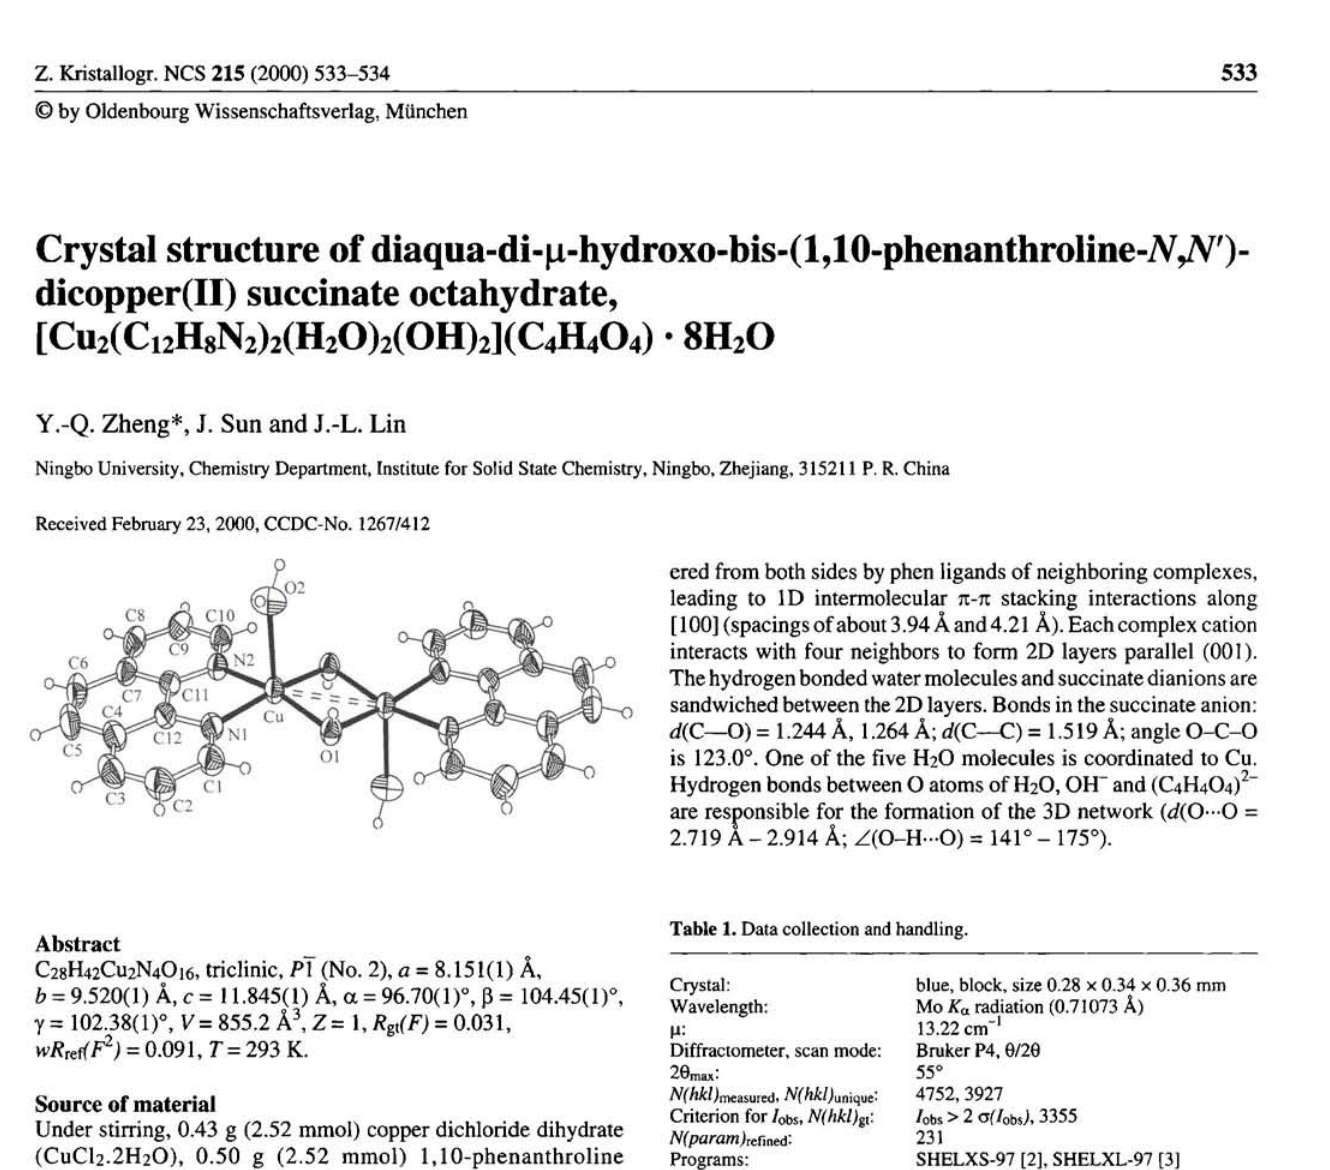
Table 2. Atomic coordinates and displacement parameters (in Â 2